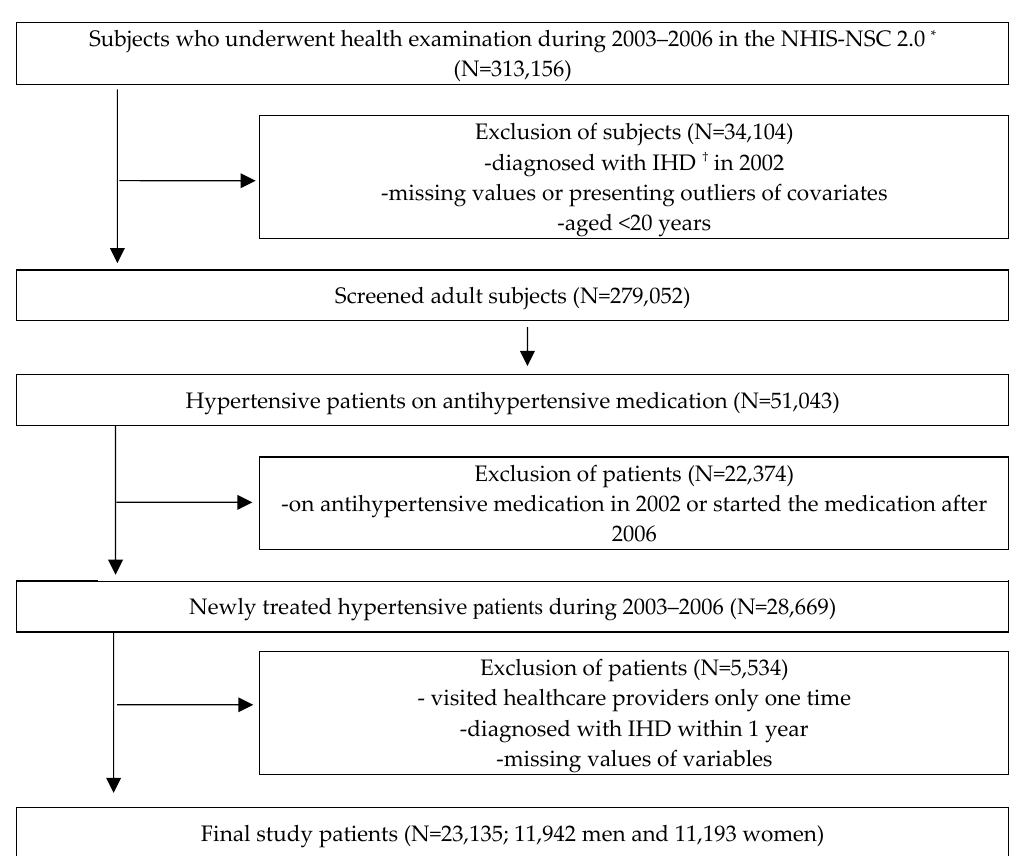
Figure 1. Flowchart of the selection process of study patients. * NHIS ‐ NSC 2.0: National Health Insurance Service ‐ National Sample Cohort version 2.0, † IHD: Ischemic heart disease.